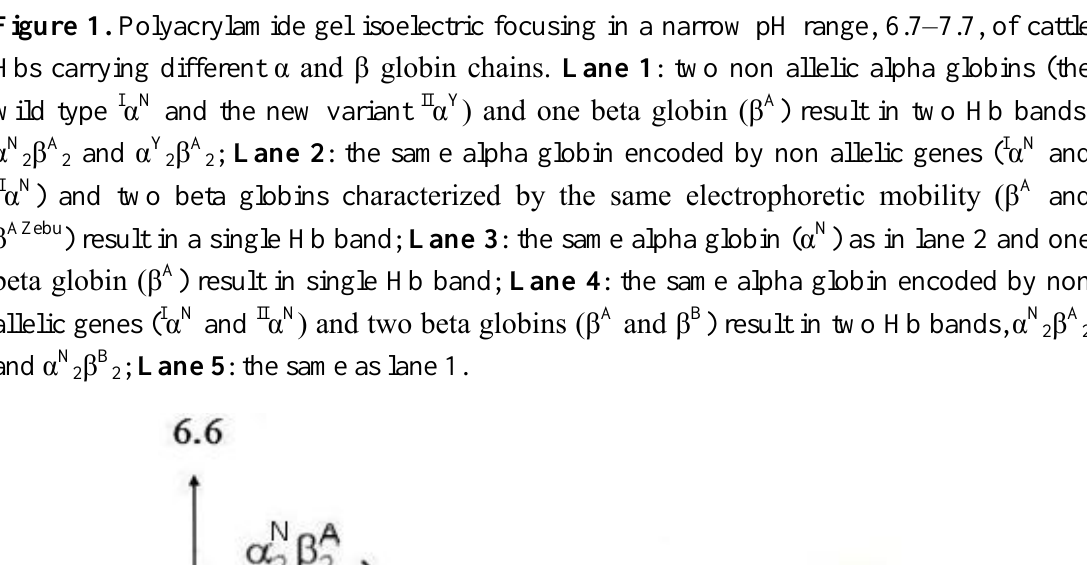
Figure 1. Polyacrylamide gel isoelectric focusing in a narrow pH range, 6.7–7.7, of cattle Hbs carrying different α and β globin chains. Lane 1 : two non allelic alpha globins (the